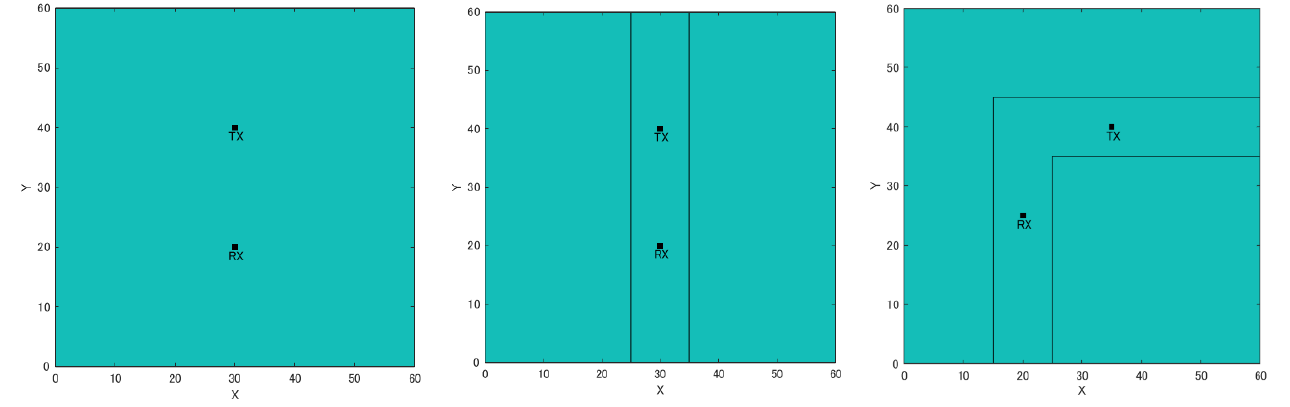
Figure 7. Artificial created maps (wilderness, straight road, and L-shaped road).